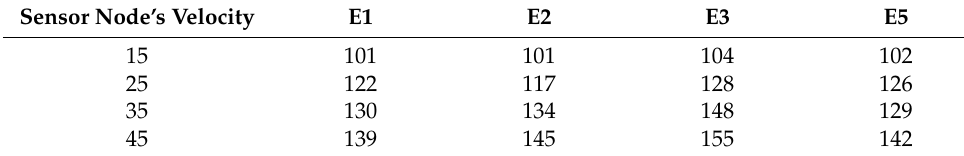
Table 8. Scheduler